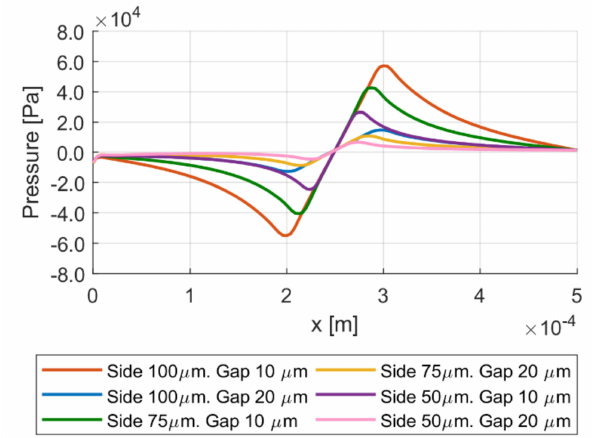
Figure 3. The pressure profile perturbation is generated by a square dimple and characterized by di ff erent sides and values of the gap. Dimple depth 10 µ m, sliding velocity 5 m / s.